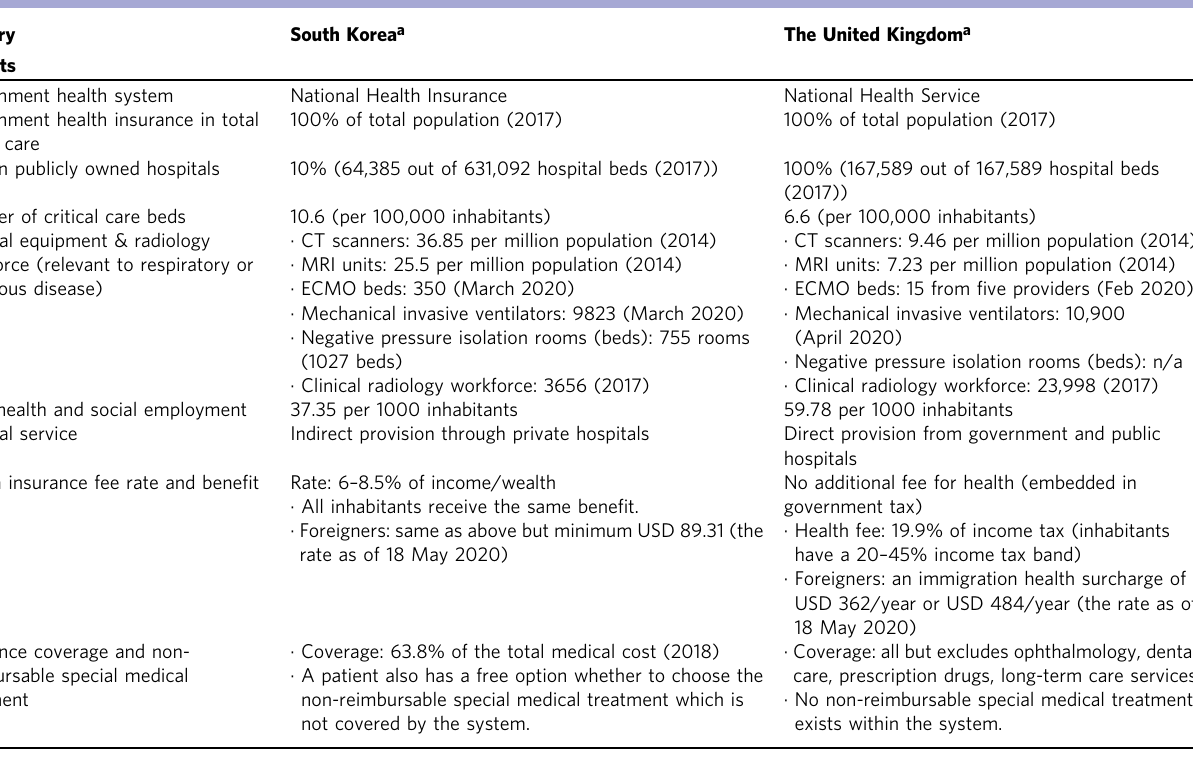
Table 1 Institutional comparison between healthcare systems of both South Korea and the UK.